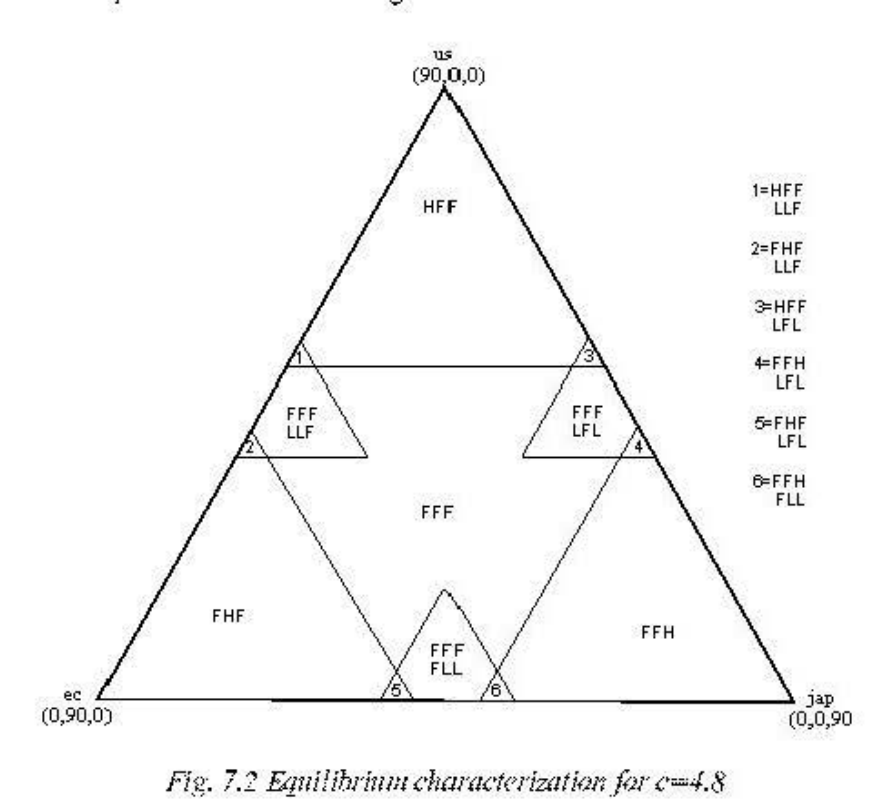
Fig. i.2 Equi ! ibrium chaml'feriwfi()r..ftJr